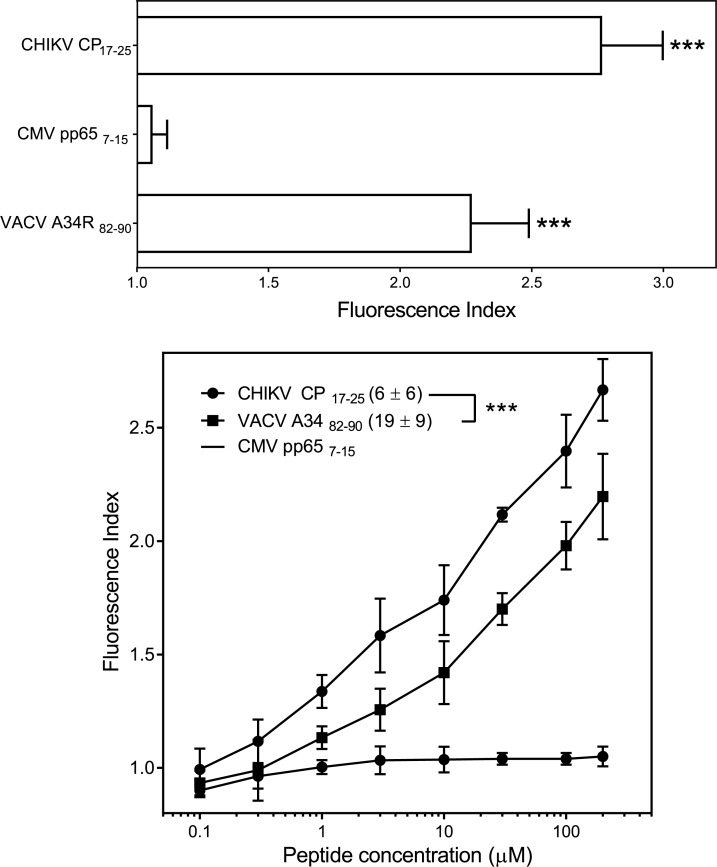
HLA-B*07:02 stabilization with CHIKV CP17-25 synthetic peptide.The stability of HLA-B*07:02-peptide complexes on the surface of transfected RMA-S cells was measured by flow cytometry. Top panel, the indicated peptides were used at 200 μM. The CMV pp657-15 and VACV A3482-90 peptides were used as negative and positive controls, respectively. The mAb ME1 was used for staining. The results, calculated as fluorescence indexes, are shown as the mean ± SD of four independent experiments. Bottom panel, titration curves for the indicated synthetic peptides with HLA-B*07:02. Results are shown as mean values ± SD from four independent experiments. Calculated EC50 values (μM; mean ± SD) are shown in the left panel insert. Significant p values with a non-parametric Mann–Whitney U test: ***, p <0.001 versus negative peptide control (CMV pp657-15, top panel) or between CHIKV CP17-25 and VACV A3482-90 viral peptides (bottom panel) are indicated.